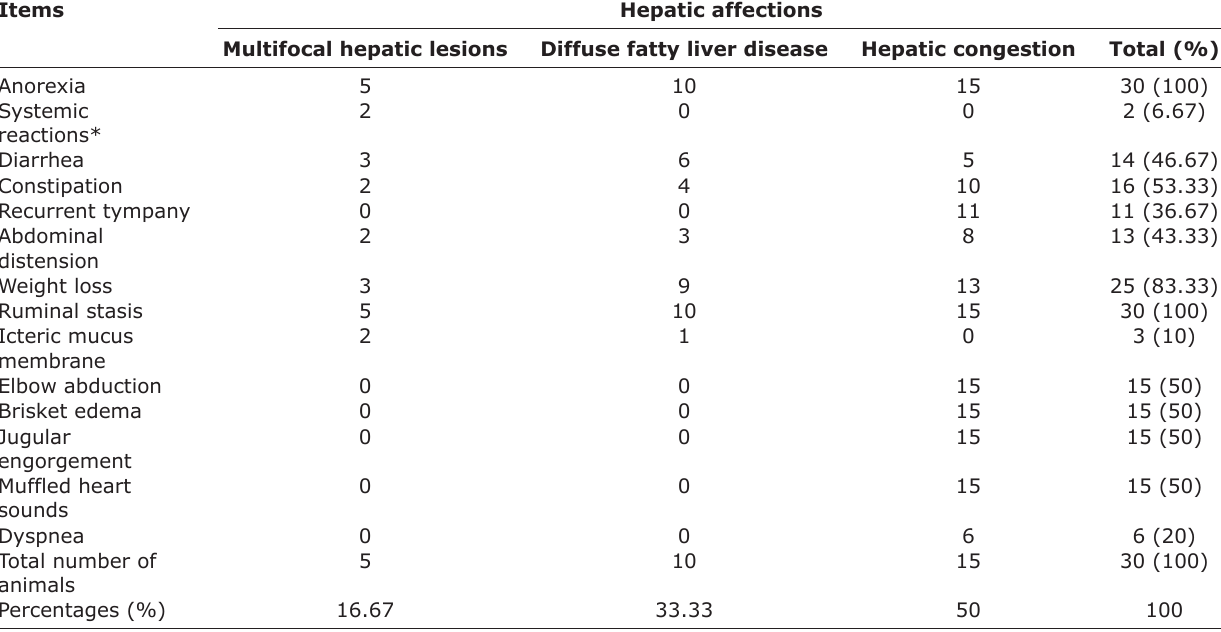
Table-1: Clinical investigations of the 30 buffaloes with hepatomegaly. Items